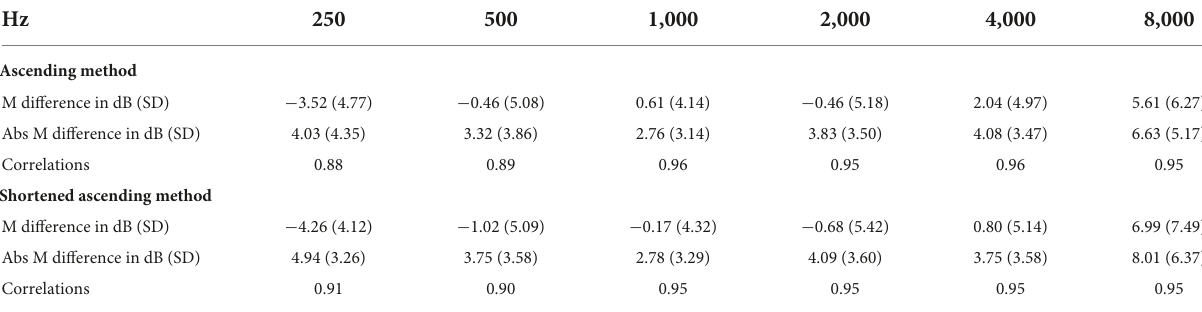
TABLE 1 The difference and correlations between manual and automated audiometry thresholds.